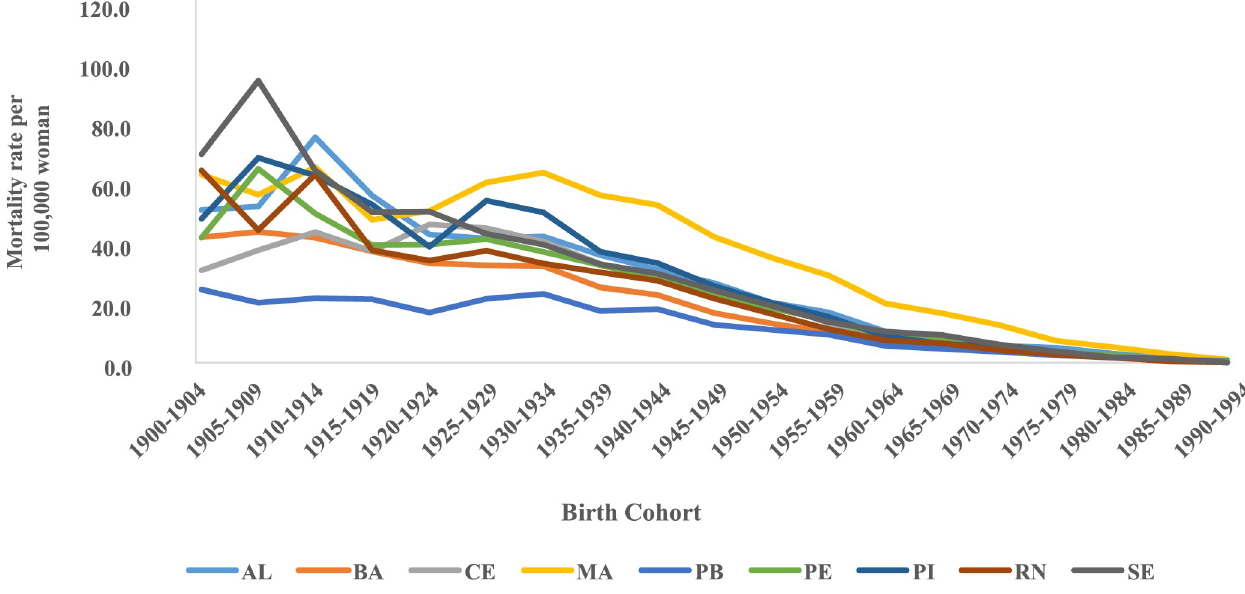
Fig 5. Average mortality rates for cervical cancer according to birth cohort, Northeastern states, Brazil, 1980–2014.